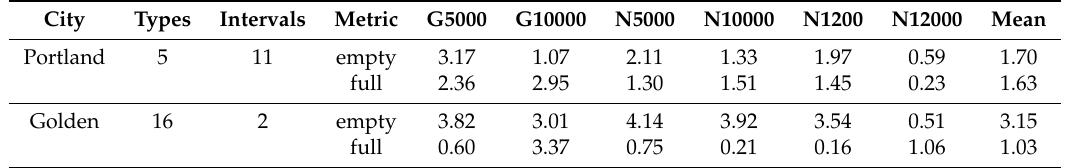
Table A1. Relative distance (in percentage) in the first series of